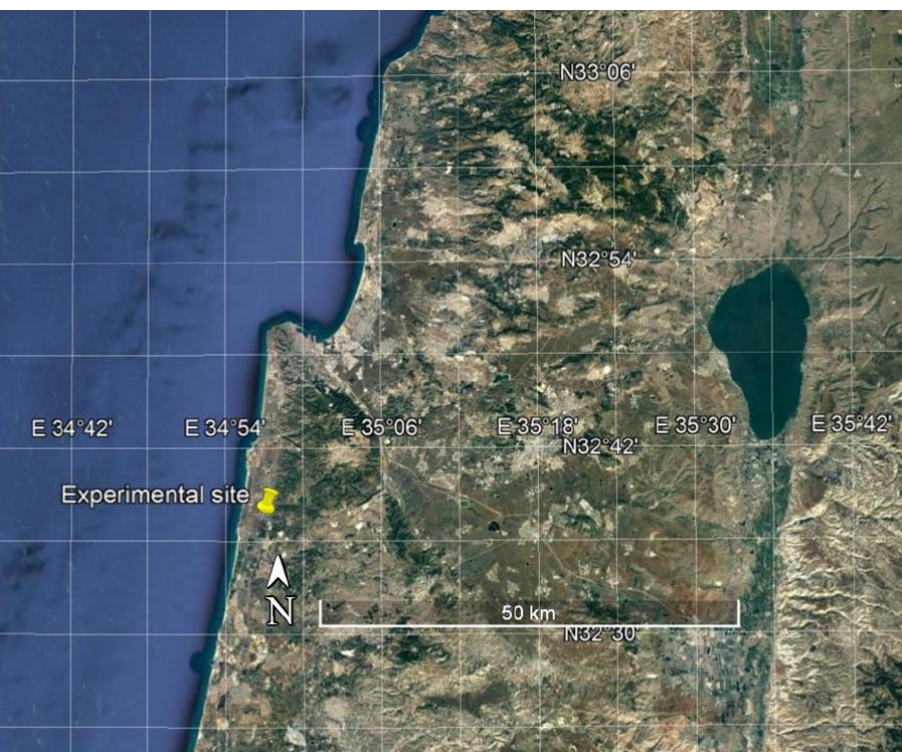
Figure 1. A map of northern Israel indicating the location of the experimental site (the yellow pin) on the Mediterranean coastal plain (source: Google Earth; retrieved on 22 March 2022).